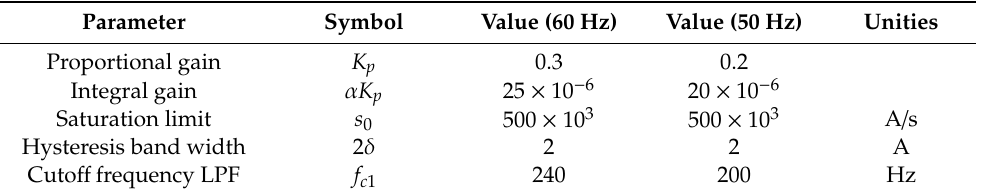
Table 2. Control parameters used in simulations.